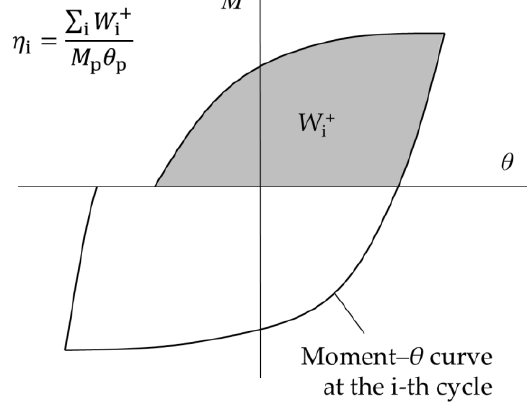
Figure A1. Energy absorbed at the i-th positive cycle.